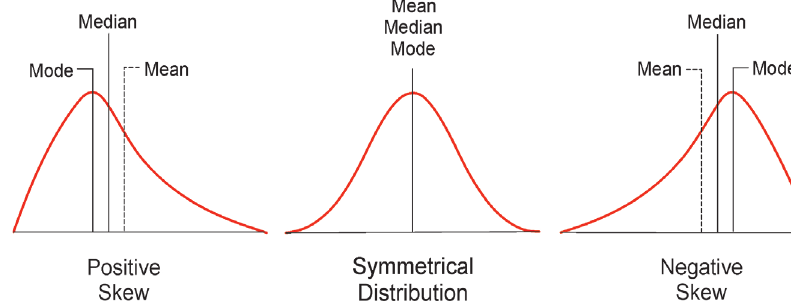
Figure 4. Skewness behavior in a normal distribution.